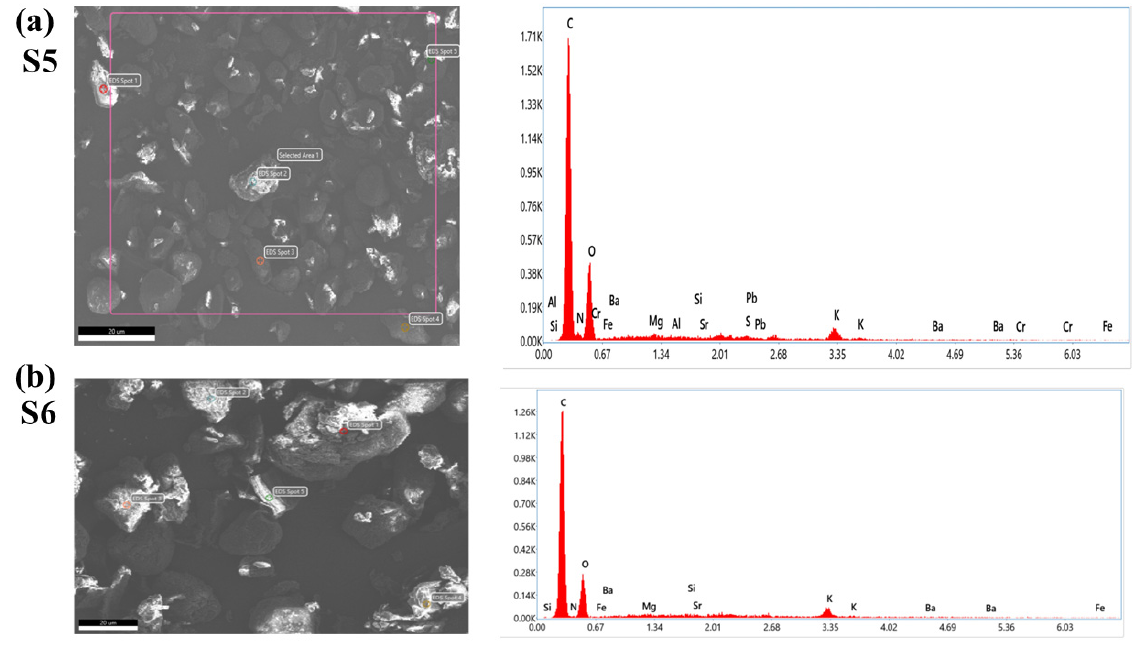
Figure 11. EDX spectra of selected turmeric samples (S5) and Sample (S6). ( a ) Sample (S5) ( b ) Sample (S6).